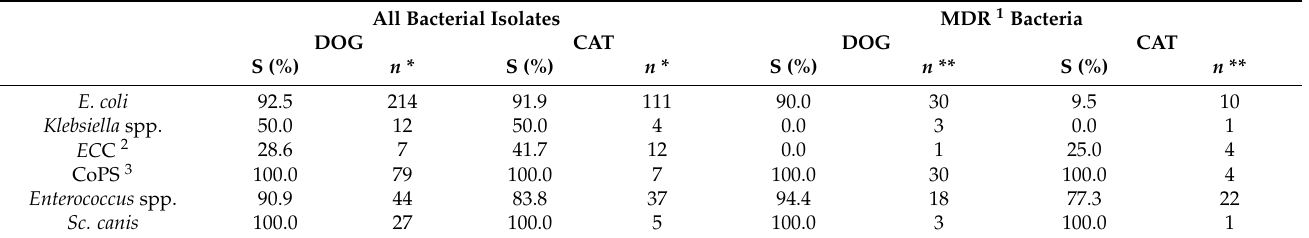
Table 8. Distribution of clinical resistance of 559 uropathogenic bacterial isolates from UTI samples in dogs ( n = 301) and cats ( n = 139) to